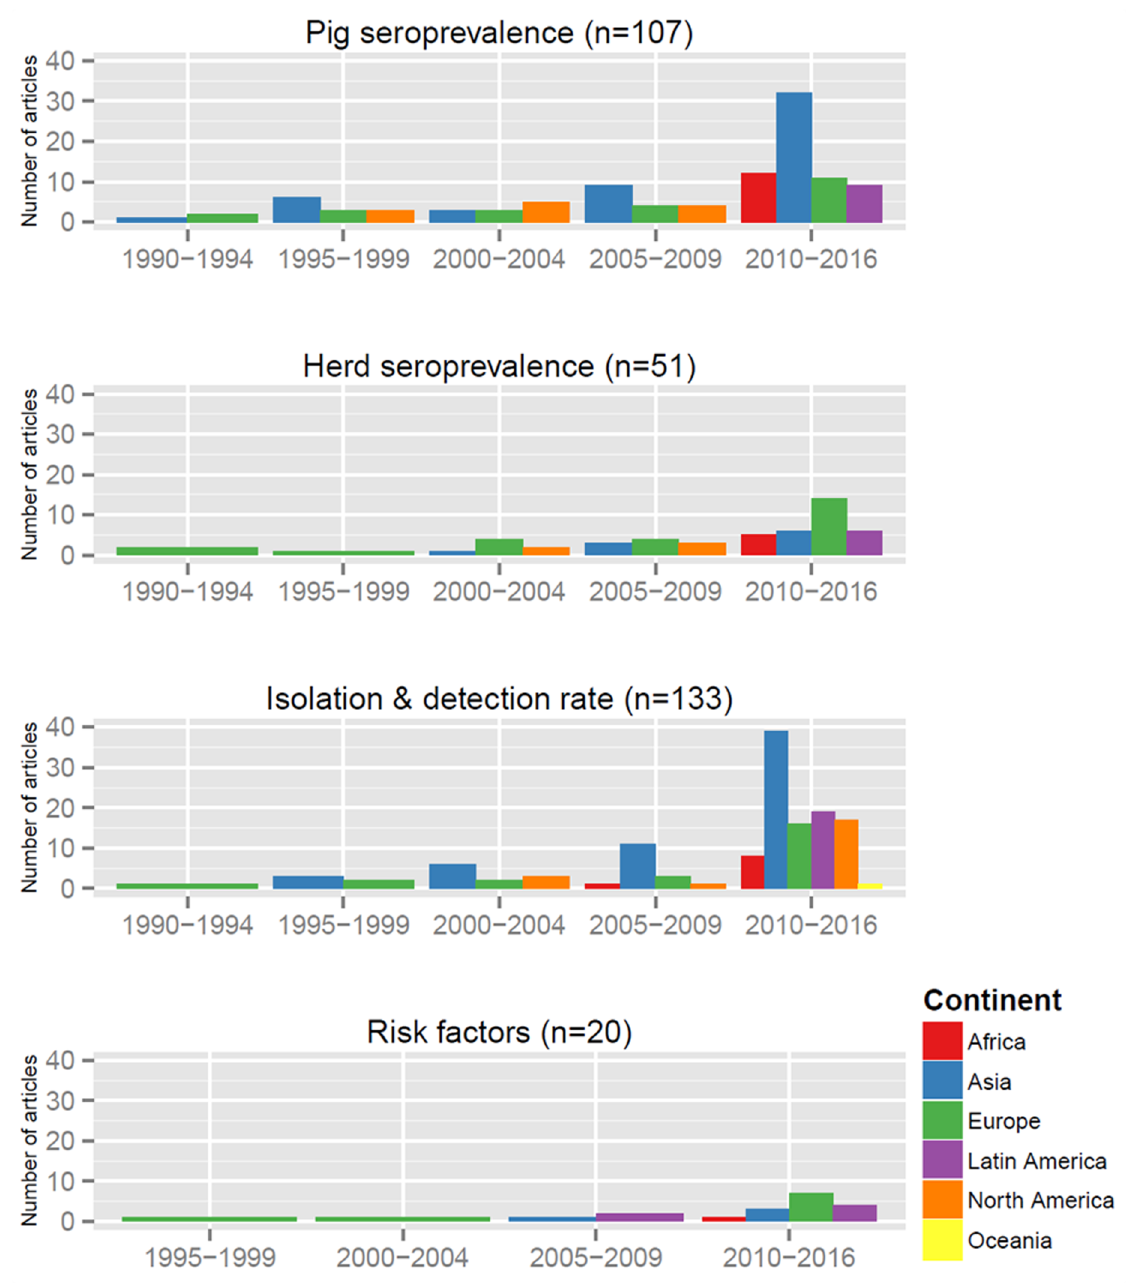
Fig 3. Distribution by year, continent and data type of the included articles. n = number of articles (some articles had data for severalcategories). N = 217 articles